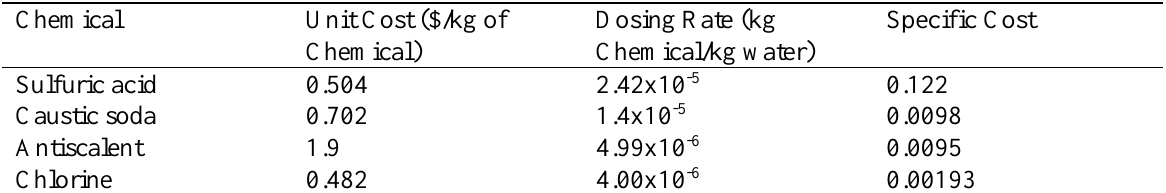
Table 2. Price of chemicals used in RO desalination unit